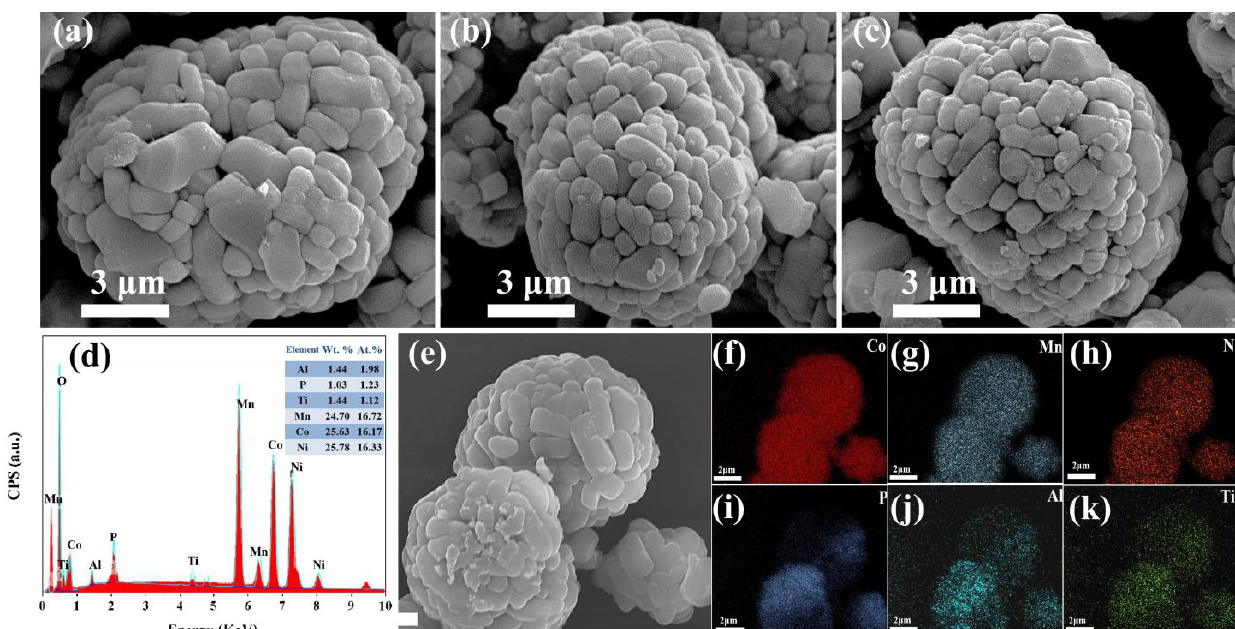
Figure 3. SEM images of ( a ) bare NCM, ( b ) NCM@0.5LATP, and ( c ) NCM@1LATP; ( d ) EDS spectrum; ( e ) area for the elemental mapping; elemental mapping of Co ( f ), Mn ( g ), Ni ( h ), P ( i ), Al ( j ), and Ti ( k ).